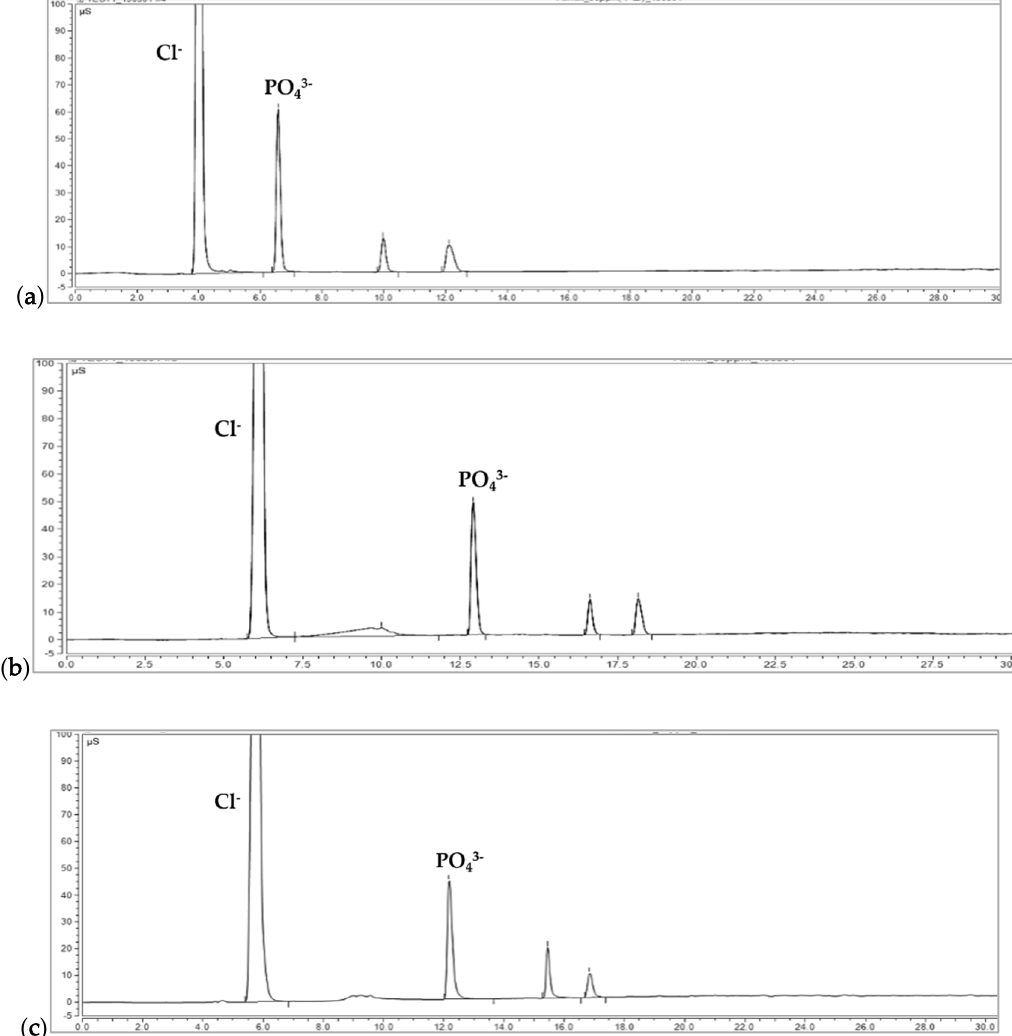
Figure 3. IC chromatograms of standard mixed solutions: ( a ) condition 1 with ASRS 300 as a suppressor at 30 ◦ C; ( b ) condition 2 with ASRS 500 as a suppressor at 35 ◦ C; ( c ) condition 3 with ASRS 300 as a suppressor at 35 ◦ C in the auto suppression external water mode. IonPac AS-16, an analytical IC column (4 × 250 mm), was used for all conditions with a guide column (4 × 50 mm). An IC method based on a Ministry of Food and Drug Safety (MFDS) report (IC condition 1) [21], which used the AS16 (4 × 250 mm) instead of AS11 (4 × 250 mm) column, showed a very large chloride ion peak in the chromatogram, followed by the peaks of PO 43 shown in Figure 3a. As expected, the peak of the chloride ion was too large, leading to the tailing